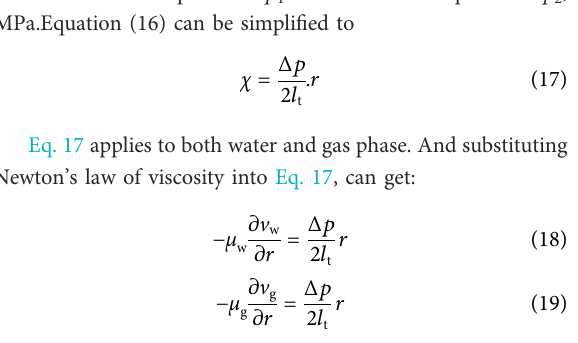
Figure 3. The length is l , the radius of the nanopore is r 0 and the radius of the bulk gas fl ow channel is r 1 .